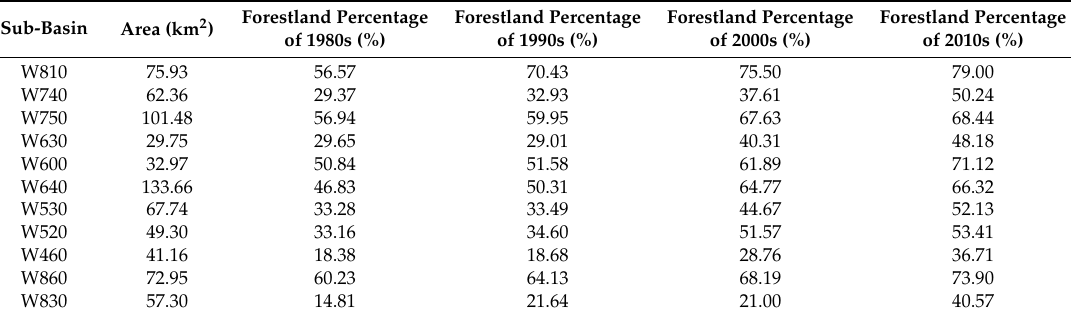
Table 9. Sub-basin area and forestland